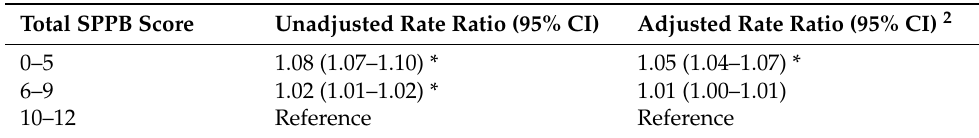
Table 3. Total SPPB score and incidence rate of probable dementia, NHATS, 2011–2018 1